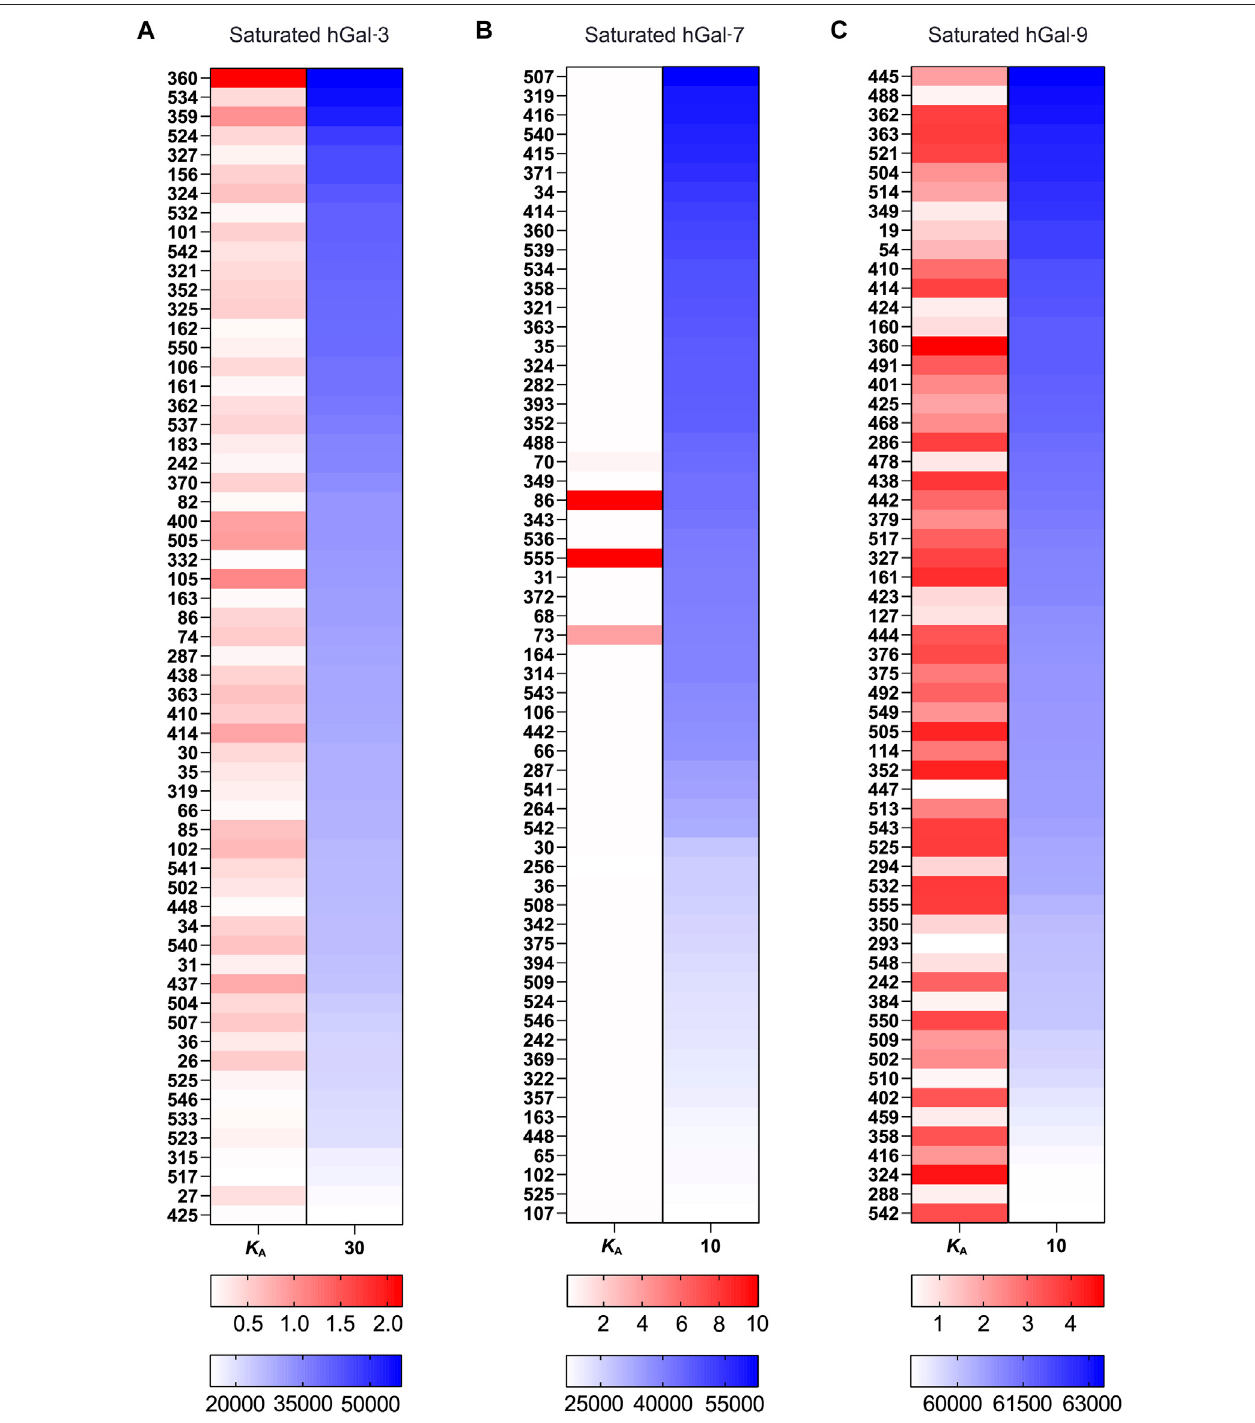
FIGURE4| Examination of K A andRFU correlation forselectedgalectin (A) Acorrelationmap withthetop60samples ’ K A andRFUvalues,sortedbyRFU,forGal- 3. (B) Acorrelationmapwiththetop60samples ’ K A andRFUvalues,sortedbyRFU,forGal-7. (C) Acorrelationmapwiththetop60samples ’ K A andRFUvalues,sorted by RFU, for Gal-9. There are two sets of gradients: red and blue to indicate binding strength, for K A and RFU, respectively. For both gradients, darker tint = higher calculated value, lighter tint = lower calculated value.